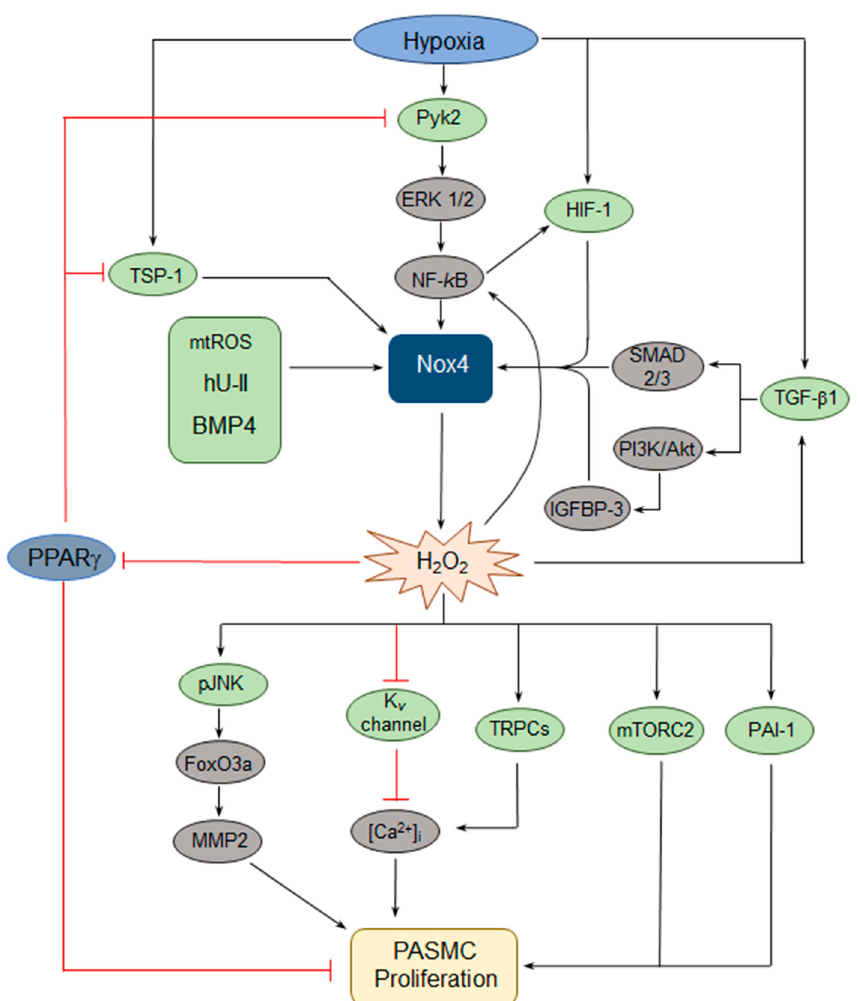
Figure 2. Schematic of key pathways involved in Nox4-mediated effects on pulmonary arterial smooth muscle cell (PASMC) proliferation. Hypoxia upregulates Nox4 via several pathways, including a proline-rich tyrosine kinase 2 (Pyk2)-extracellular signal-regulated kinase (ERK 1/2)-nuclear factor-kappa B (NF-kB) axis, hypoxia-inducible transcription factor 1 (HIF-1), transforming growth factor β 1 (TGF- β 1), and thrombospondin-1 (TSP-1). Other activators of Nox4 include human urotensin II (hU-II), bone morphogenetic protein 4 (BMP4), and mitochondrial reactive oxygen species (mtROS). Importantly, several of these pathways include feed-forward loops, some of which feature peroxisome proliferator-activated receptor γ (PPAR γ ) as a key component. Downstream effectors of Nox4-derived hydrogen peroxide (H 2 O 2 ) include phosphorylated c-Jun-NH(2)-terminal kinase (pJNK), mammalian target of rapamycin 2 (mTORC2), plasminogen activator inhibitor-1 (PAI-1), and multiple pathways that increase intracellular calcium ([Ca 2+ ] i ). PI3K = phosphatidylinositol 3-kinase; Akt = protein kinase B; IGFBP-3 = insulin-like growth factor binding protein-3; FoxO3a = Forkhead Box O3a; MMP2 = matrix metalloproteinase 2; K v = voltage-gated potassium; TRPC = transient receptor potential channel. Additional pathways involved in hypoxic upregulation of Nox4 have been defined, including